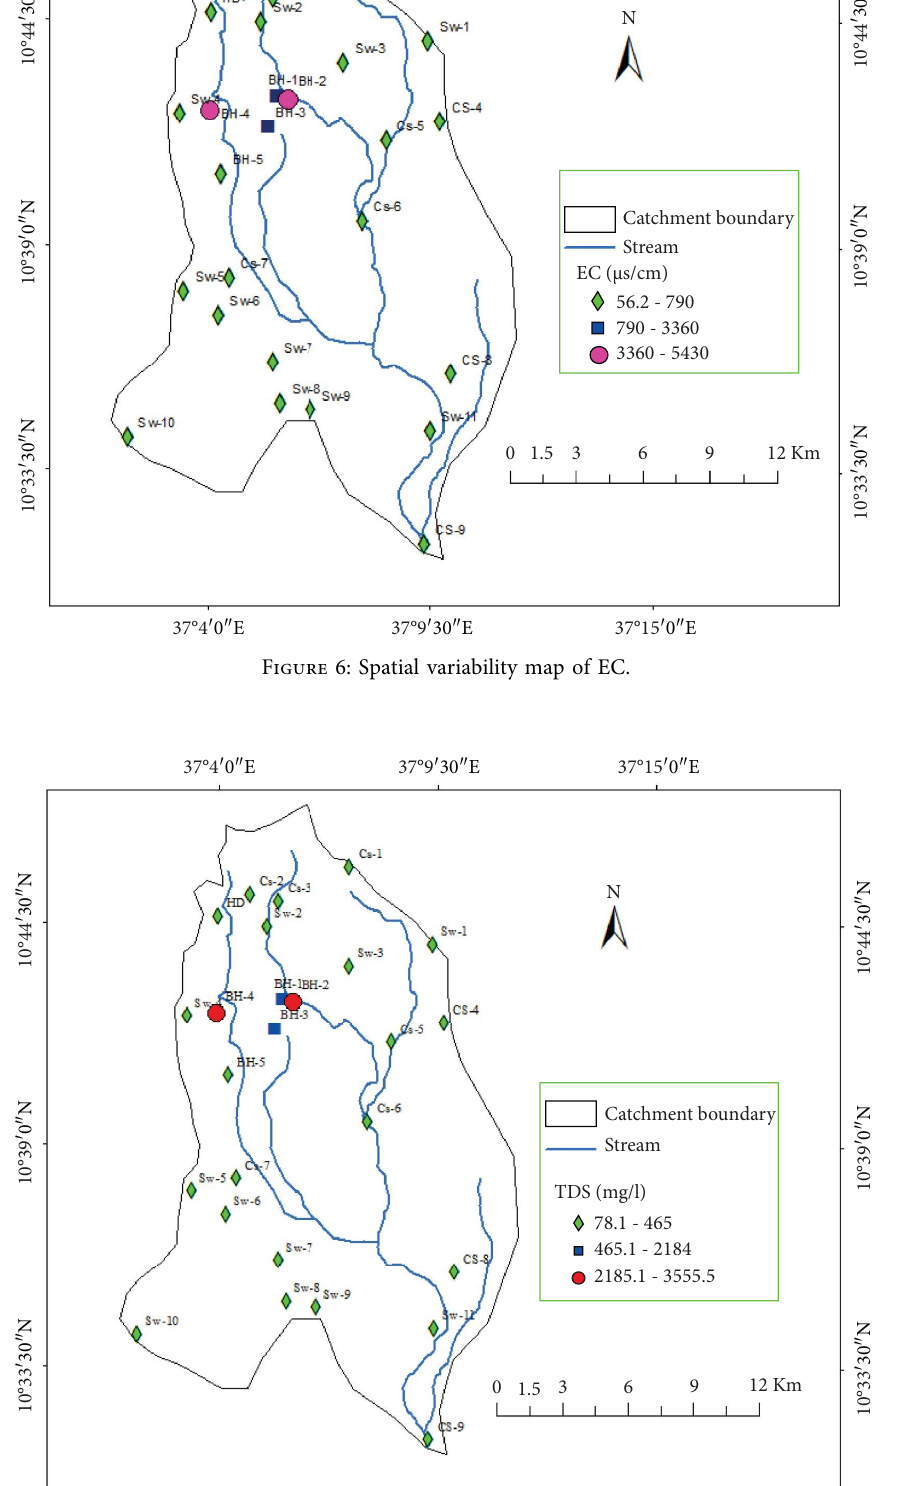
Figure 7: Spatial variability map of